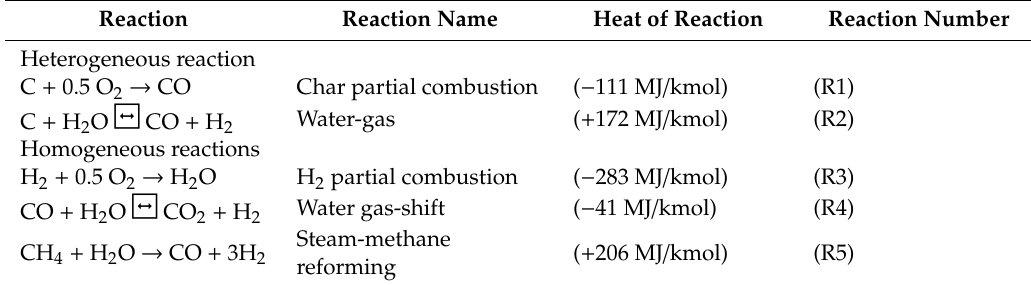
axis of the cylinder in order to calculate the syngas composition. In this model, the pyrolysis reactions were considered instantaneous, because the operating temperature is quite high in the gasifier where biomass is fed. For this reason, the de-volatilization time was considered negligible, assuming that biomass is instantaneously converted in its de-volatilization products. In order to obtain realistic values for the pyrolysis products and to validate the biomass steam gasification model, experimental tests on a bench scale fluidized bed reactor were used [41]. A hydrodynamic model according to Kunii and Levenspiel [42] (Geldart group B powder) was used to describe the bubble and emulsion phases and their interaction in the fluidized bed. The rates of the gasification reactions (heterogeneous and homogeneous reactions, including one-ring tar reforming) have been implemented using literature kinetic correlations [9]. In Figure 2 the MATLAB algorithm flow chart is illustrated, more details of the model can be found in the works of Di Carlo et al.